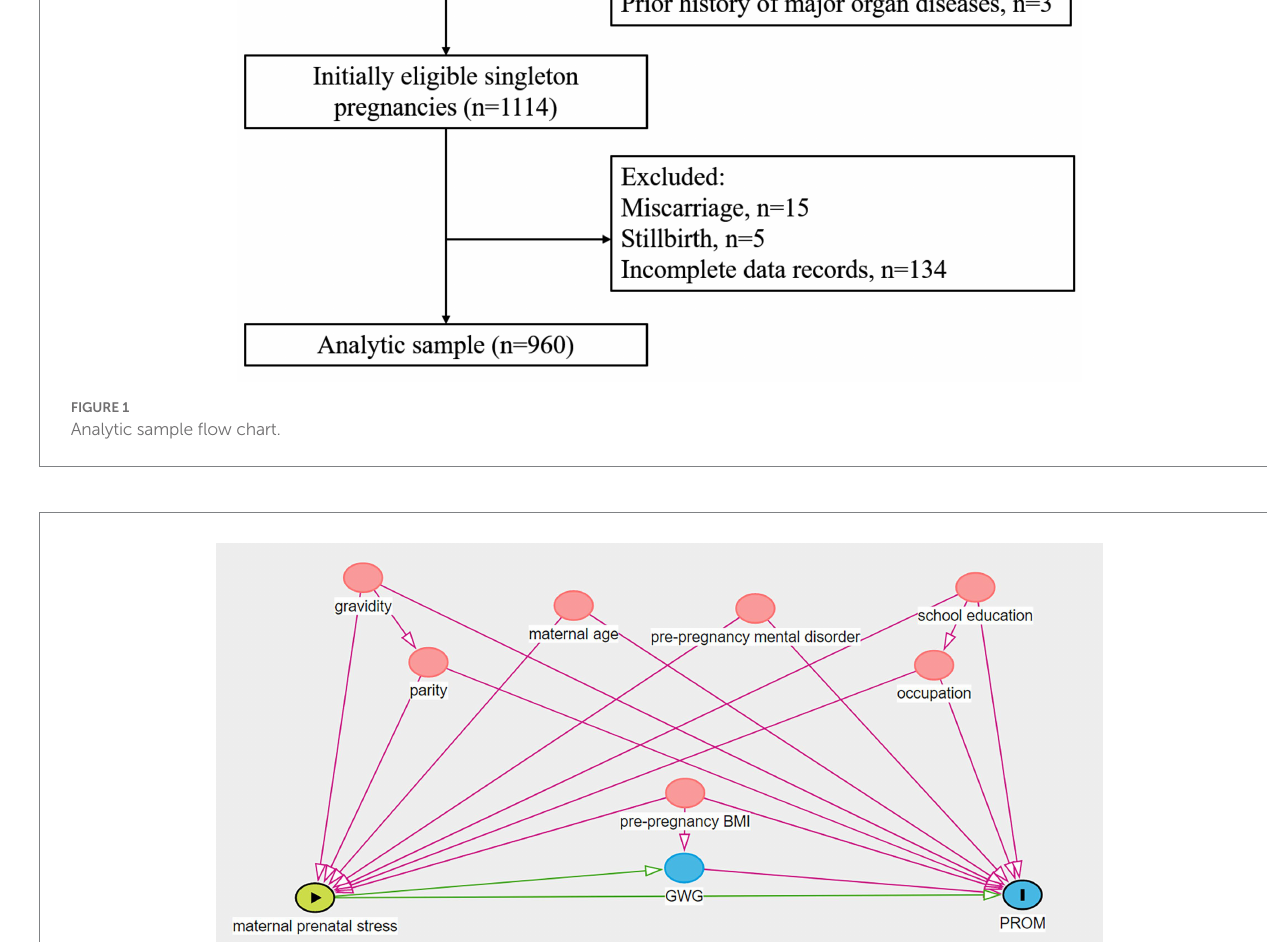
FIGURE 2 The directed acyclic graph illustrating confounding factors in the stress-PROM